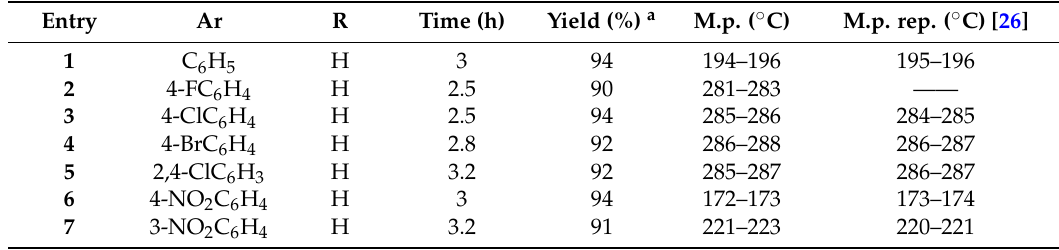
Table 2. One pot, four-component synthesis of pyrazolo-[4 ′ ,3 ′ :5,6]pyrido[2,3- d ]pyrimidine-diones in refluxing water using a catalytic amount of nano-ZnO.